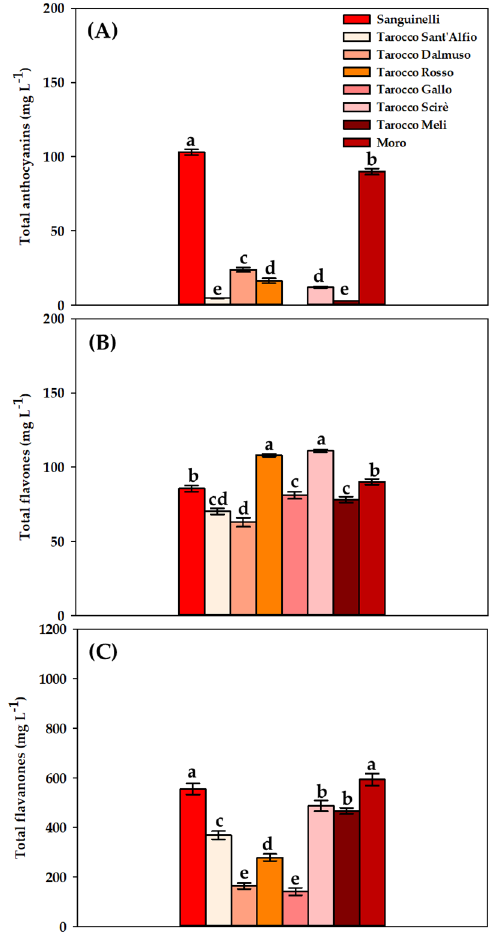
Figure 3. Total content of anthocyanins ( A ), flavones ( B ), and flavanones ( C ) in juice of eight blood orange varieties (Sanguinelli, Tarocco Sant’Alfio, Tarocco Dalmuso, Tarocco Rosso, Tarocco Gallo, Tarocco Scirè, Tarocco Meli and Moro) grafted on Citrus macrophylla . Data are the mean ± SE ( n = 6). Di ff erent le tt ers indicate statistically signi fi cant di ff erences (ANOVA, HSD Tukey test; p < 0.05). Flavones oscillated signi fi cantly from 62.74 mg L − 1 to 111.75 mg L − 1 . The Tarocco Dal- muso variety was the lowest in this chemical marker matrix, followed by Tarocco Sant(cid:31)Al- fi o, Tarocco Meli, Tarocco Gallo, Sanguinelli and Moro whose values were all below 100 mg L − 1 . The highest values, greater than 100 mg L − 1 , were found in Tarocco Scirè, followed